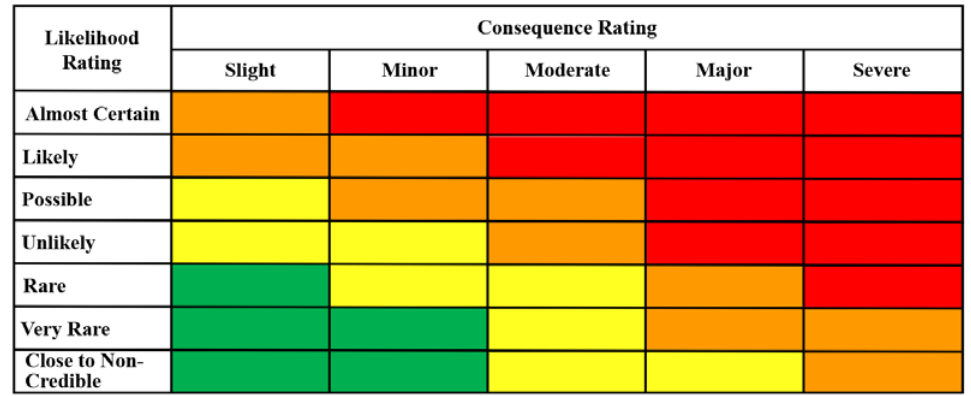
Figure A5. Colour-coded risk matrix following application of hazard aversion. 7.